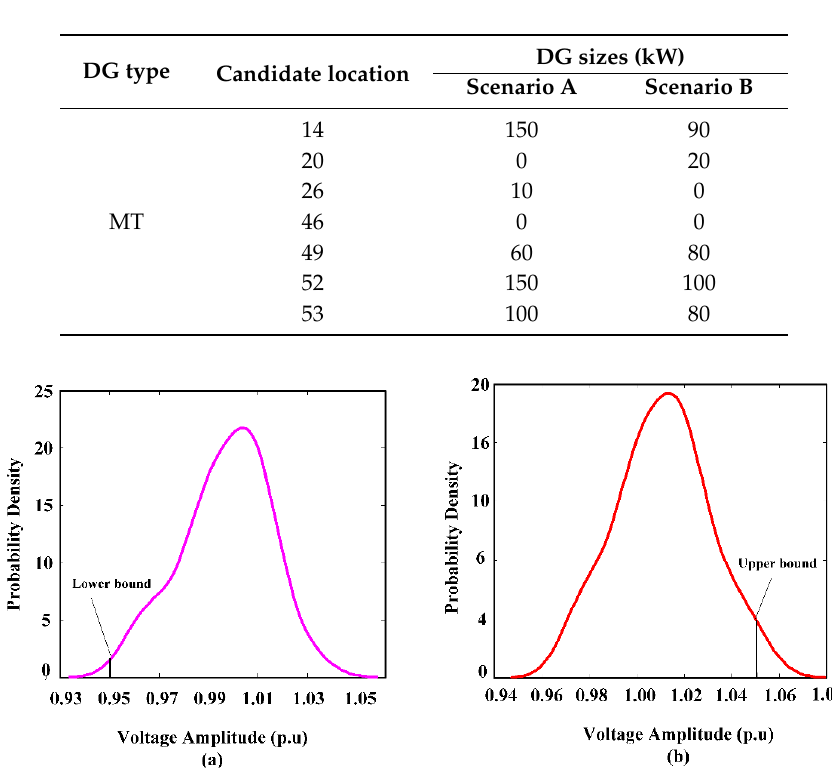
Figure 7. PDF curve of voltage amplitude in Scenario A of 33 ‐ bus system: ( a ) Node 32 and ( b ) Node 4.